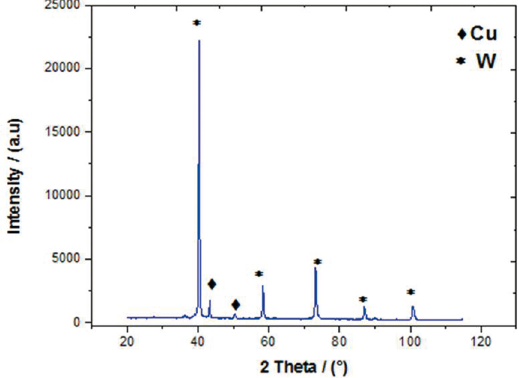
Figure 7. X-ray diffraction of W-30 wt% Cu composite powder.